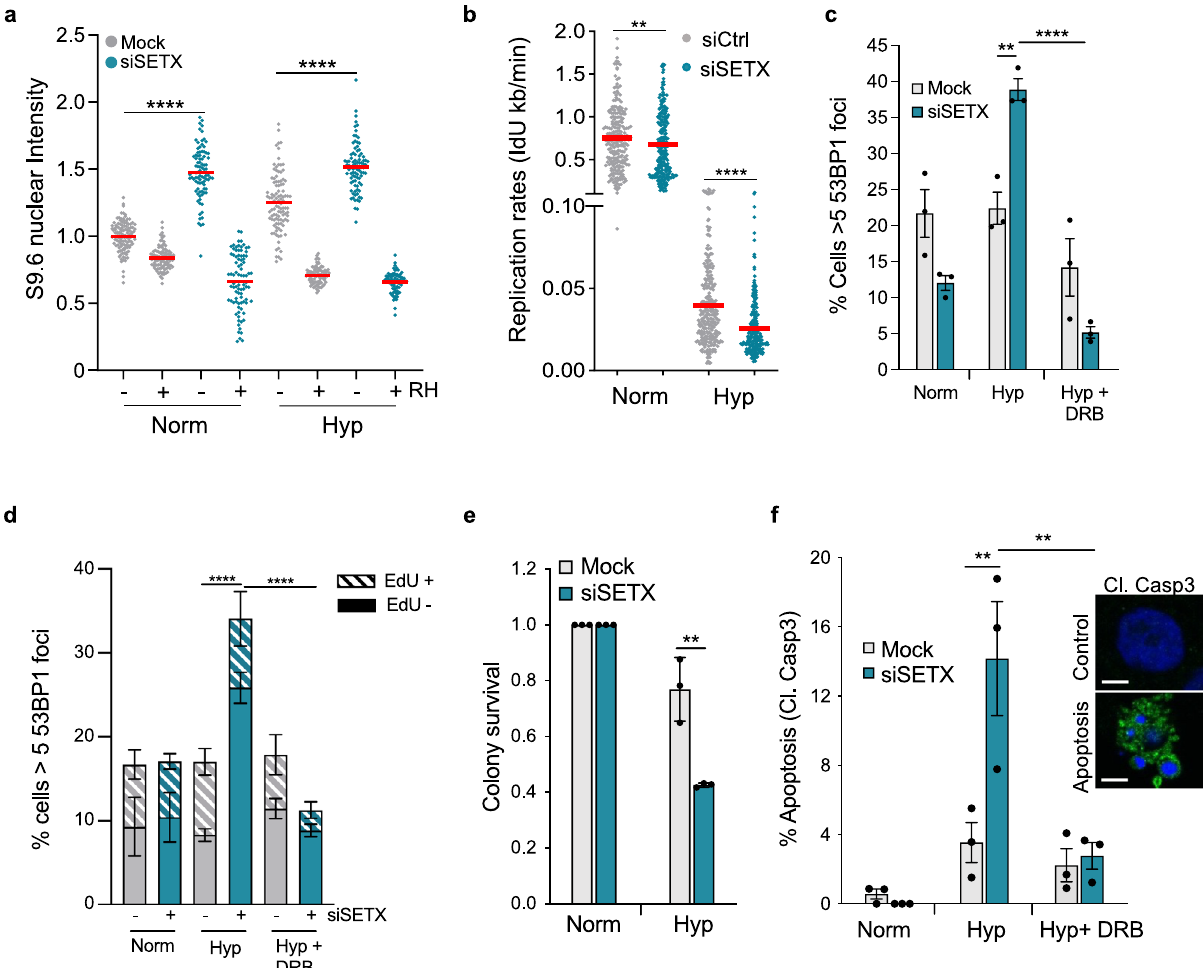
Fig. 4 SETX reduces R-loops and protects from DNA damage and cell death in hypoxia. a A549 cells that were either mock-transfected (grey) or transfected with SETX siRNA (green), were exposed to 21% O 2 or <0.1% O 2 for 12 h. Cells were fi xed and stained with the S9.6 antibody and DAPI. Where indicated, coverslips were treated with RNase H prior to staining. Data from one independent experiment (n = 1) where each dot represents a cell and a minimum of 100 cells were imaged per treatment. b Replication rates, as determined by IdU incorporation rates, of RKO cells transfected with control siRNA versus SETX siRNA exposed to 21% O 2 (Norm) or <0.1% O 2 (Hyp) for 6 h. Data from three independent experiments ( n = 3) where each dot represents a fi bre and a minimum of 100 fi bres were analysed per treatment. Two-tailed Mann – Whitney U test was used: **** p < 0.0001, * p = 0.0068. c Percentage of cells displaying 53BP1 foci (>5 per nucleus) in RKO cells with either mock-treated or treated with SETX siRNA. Cells were exposed to 21% O 2 (Norm), 6 h of <0.1% O 2 (Hyp) or pre-treated with DRB (100 µ M) followed by 6 h of <0.1% O 2 (Hyp + DRB). One-way ANOVA Tukey ’ s multiple comparisons test was used: ns p = 0.1240, ** p = 0.0046, **** p < 0.0001. d A549 cells that were either mock-transfected (grey) or transfected with SETX siRNA (green) were pulsed with EdU (10 µ M) for 1 h then and exposed to 21% O 2 (Norm), <0.1% O 2 (Hyp) for 6 h or treated with DRB (100 µ M) in <0.1% Colony survival of A549 cells with either mock treatment or SETX siRNA after 0 and 18 h of hypoxia (Hyp) (<0.1% O 2 ) treatment. Two-tailed Student ’ s t - test was used: p = 0.0065. f A549 cells were mock-treated or treated with SETX siRNA and exposed to 21% O 2 (Norm), <0.1% O 2 (Hyp) for 24 h or pre- treated with DRB (100 µ M) followed by 24 h of <0.1% O 2 (Hyp + DRB). The percentage of cells positive for cleaved caspase 3 (Cl. Casp3) is